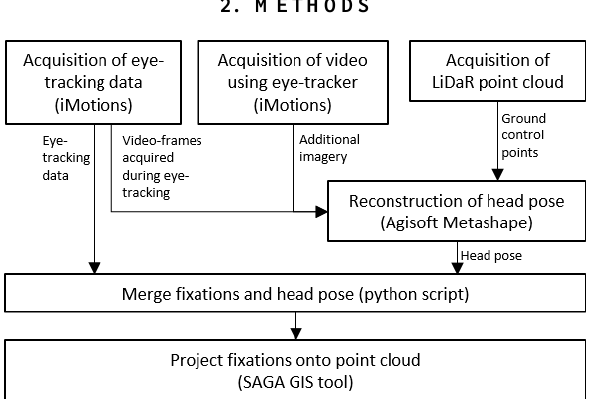
Figure 1. Workflow for 3D reconstruction and projection of fixations.